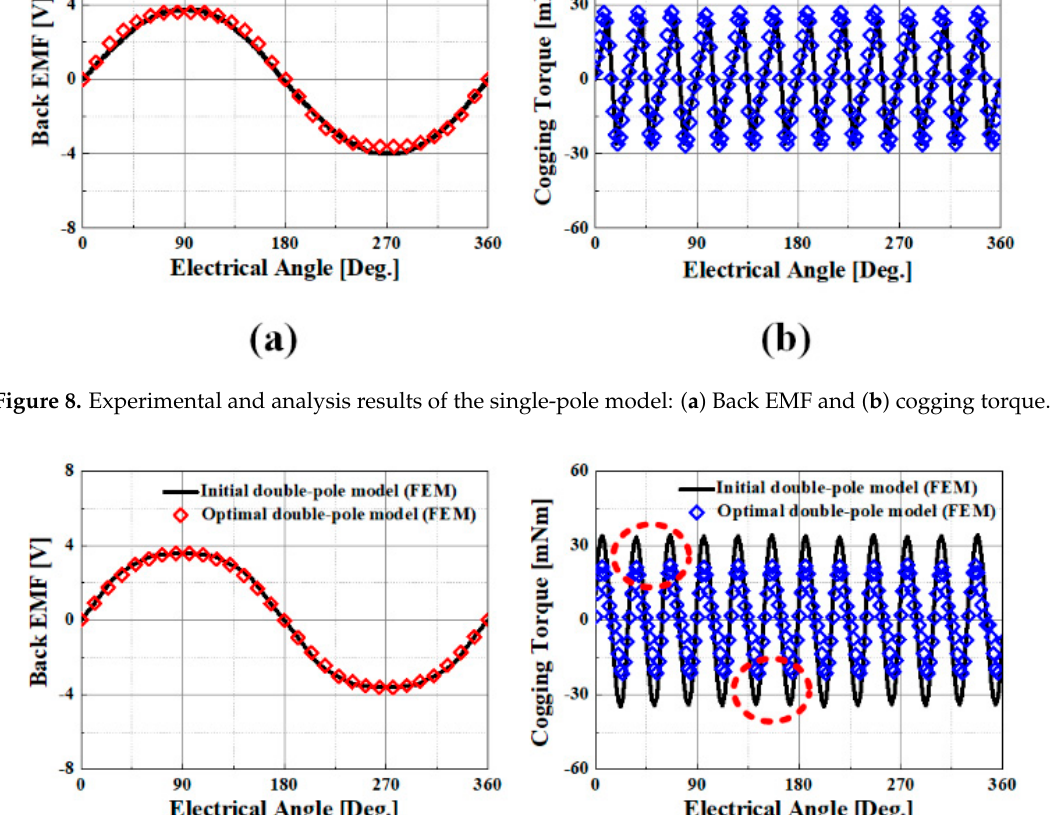
Figure 9. Analysis results of the initial and optimal double-pole models: ( a ) Back EMF and ( b ) cogging torque.